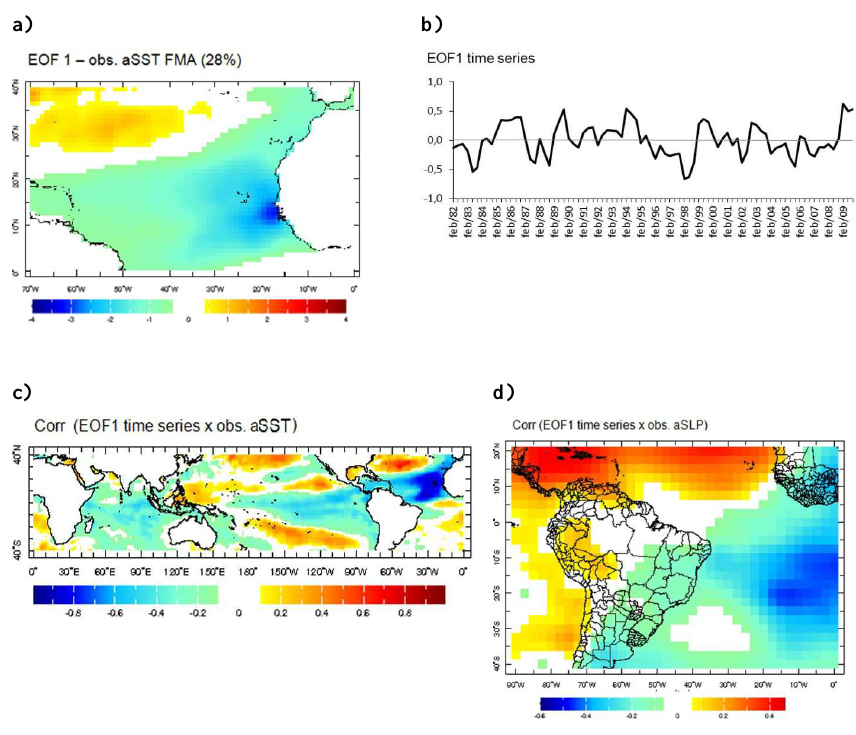
Fig. 7. As in Fig. 6 but for the North Atlantic